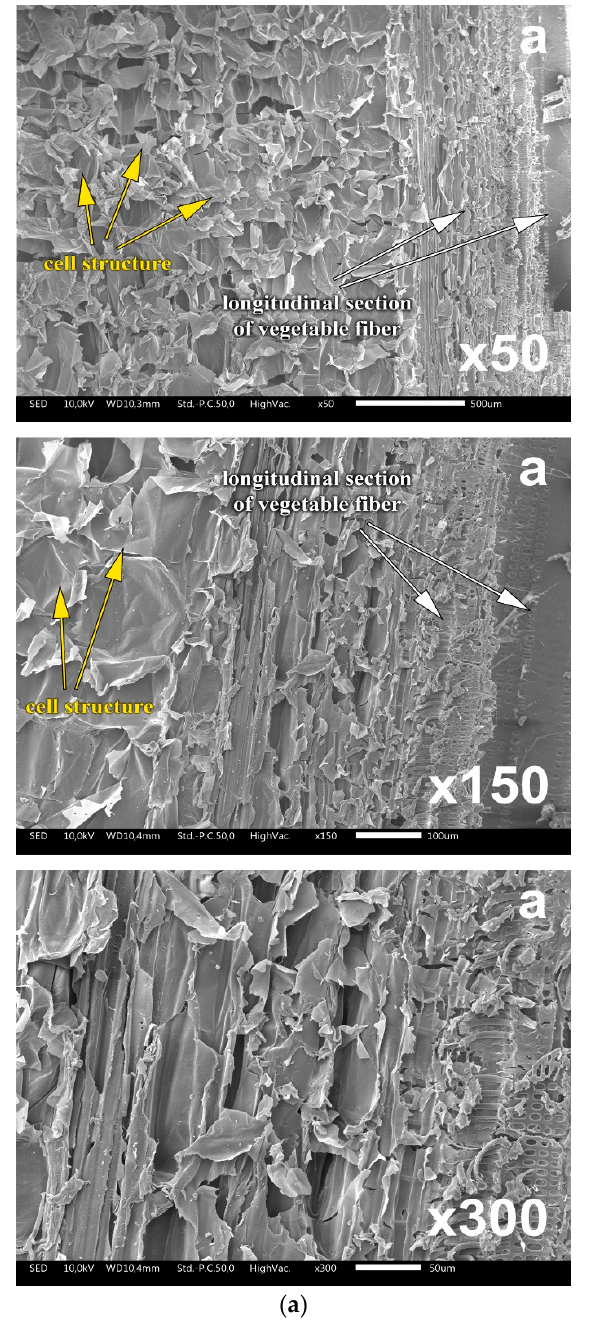
Figure 7. SEM micrographs of Buriti foam with magnifications of ×50, ×150, and ×300: ( a ) longitudinal surface and ( b ) transverse surface.